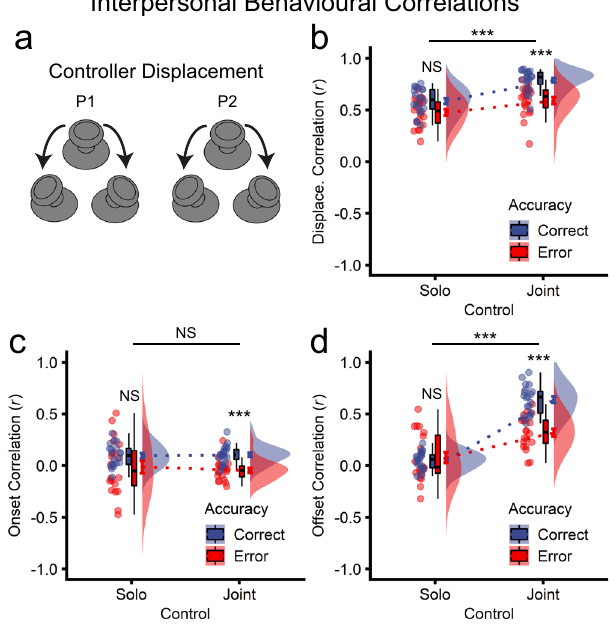
Fig. 5 Effects of joint control on interpersonal behavioural correlations ( n = 20 pairs). a Controller displacement was calculated as the Euclidean displacement from the controller home position, ranging from 0 to 100%. The equation for displacement is given by the Pythagorean equation ffiffiffiffiffiffiffiffiffiffiffiffiffiffiffi p x 2 þ y 2 , where x and y refer to the horizontal and vertical components, respectively. Displacement was calculated at each frame, creating a time series of displacement values. Within-pair (Pearson, zero-lag) correlations were calculated between co-actors ’ controller displacement time series for each trial. b Grand mean controller displacement correlations for solo and joint control actions, shown in different colours for correct (red) and error (blue) trials. c Action onset correlations. Onsets for each trial were calculated separately for each co-actor on solo and joint trials as the fi rst frame of movement showing displacements greater than 10% of maximum. d Action offset correlations. Offsets were calculated separately for each co- actor as the last frame of movement showing displacements greater than 10% of maximum. Onsets and offsets, calculated for each trial, were then separately correlated between participant pairs across